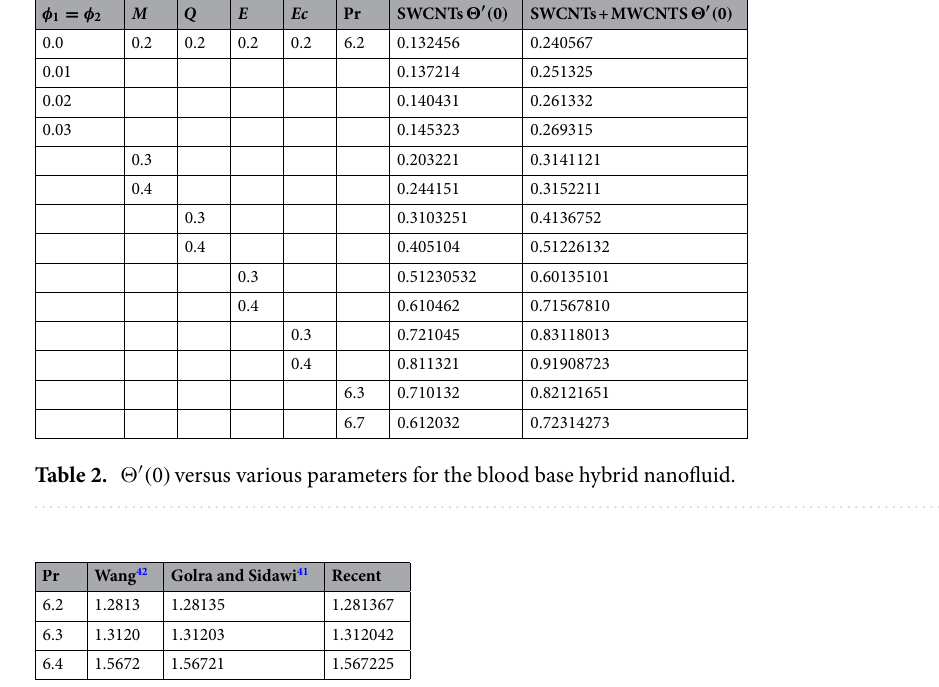
Table 3. Comparison with 41,42 taking the similar parameters and excluding diverse